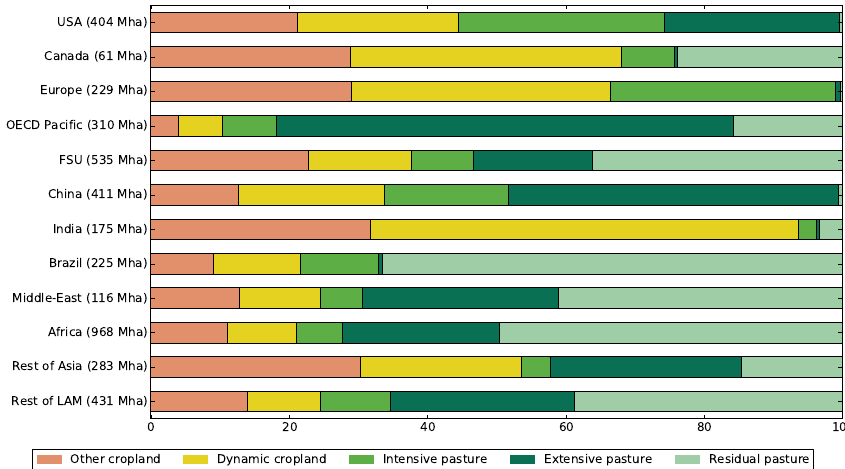
Intensive pasture Extensive pasture Residual pasture